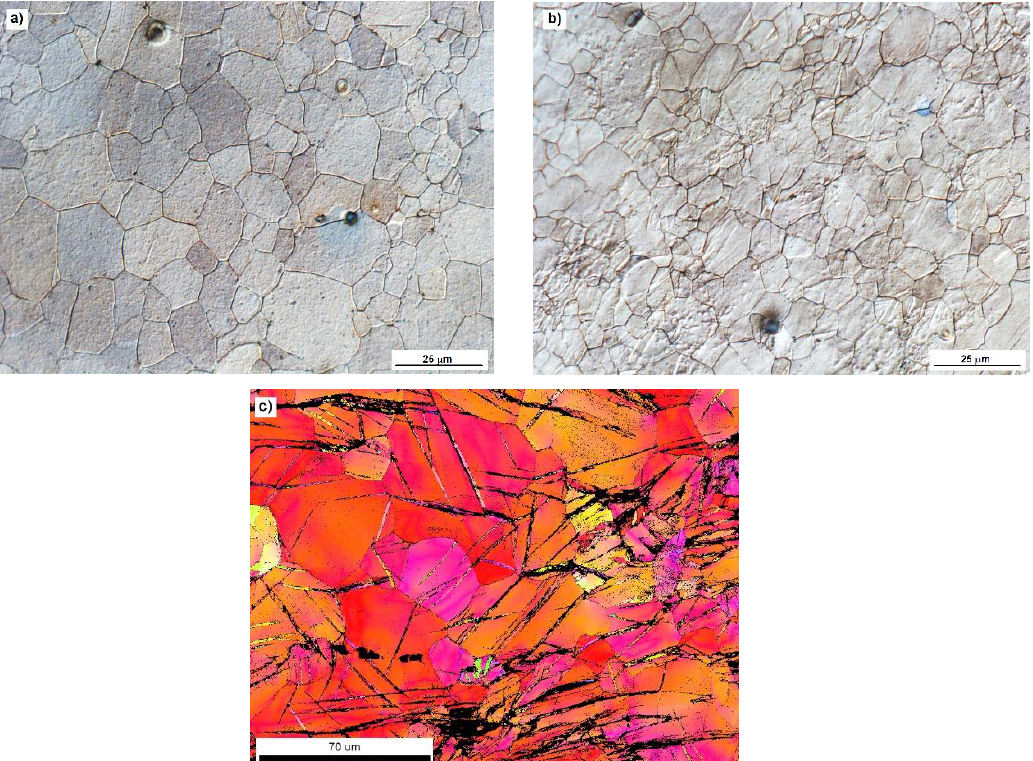
Figure 8. Microstructure of the 45 samples deformed to ( a ) 225 MPa, ( b ) 270 MPa observed by light microscopy and ( c ) sample deformed to fracture observed by EBSD.